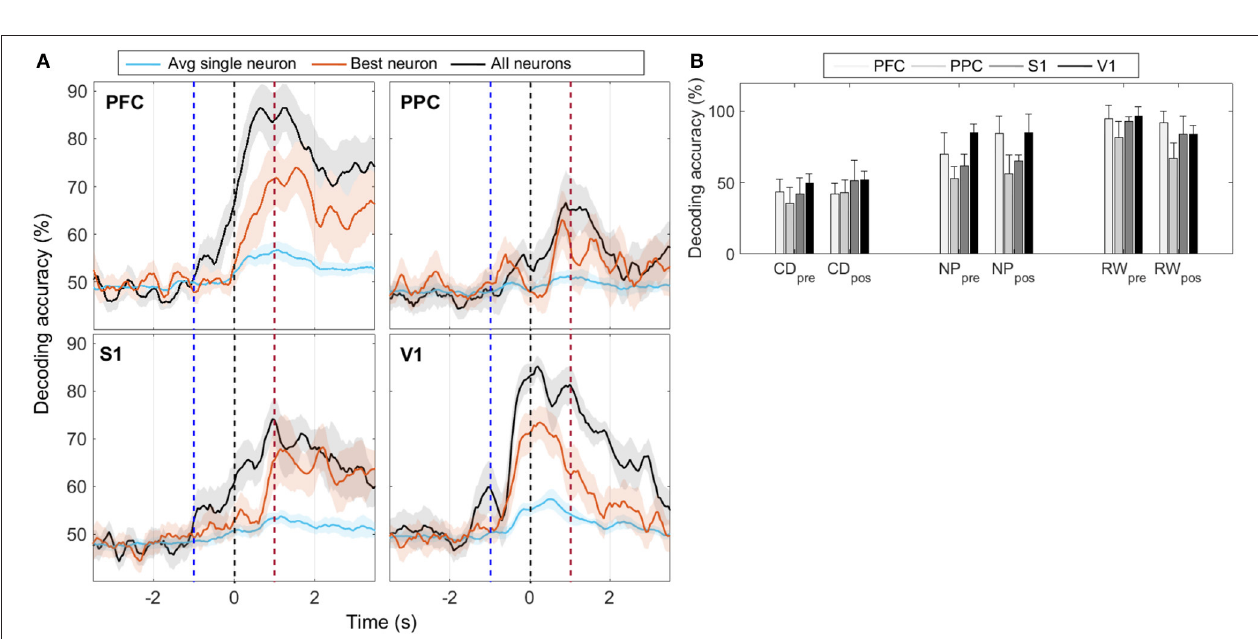
FIGURE 4 | Multiphasic neurons mean firing rate (bin 50 ms, no overlap, z-scored) of all animals in each of the four recorded cortical areas. Red (black) lines depict = the activity when reward was at the left (right) hand side. Time t 0 s marks the moment rats reach the NP. Shaded regions relate to the standard error of the mean = (calculated across the total number of recorded cells, described in Table 2 ). Curves are smoothed with a 10-point moving average filter. Dashed blue (red) vertical lines indicate the approximate beginning of trials (reward) time.